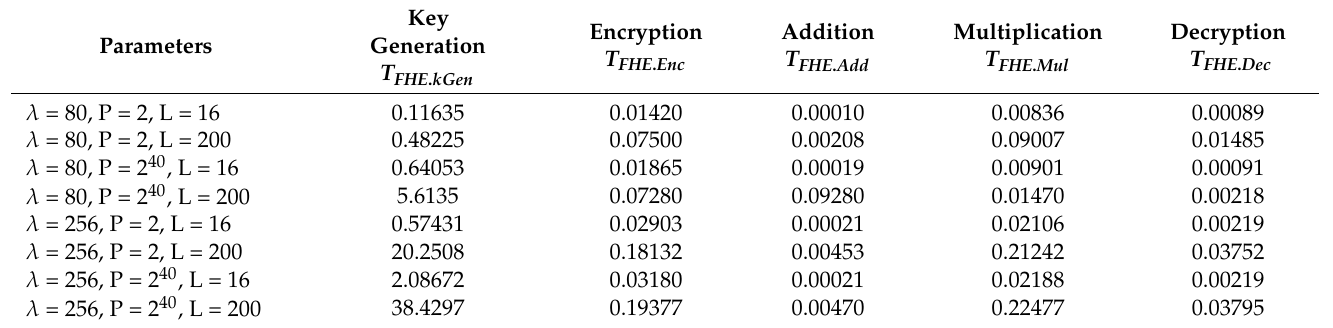
Table 3. Time cost for fully homomorphic encryption (FHE, s).